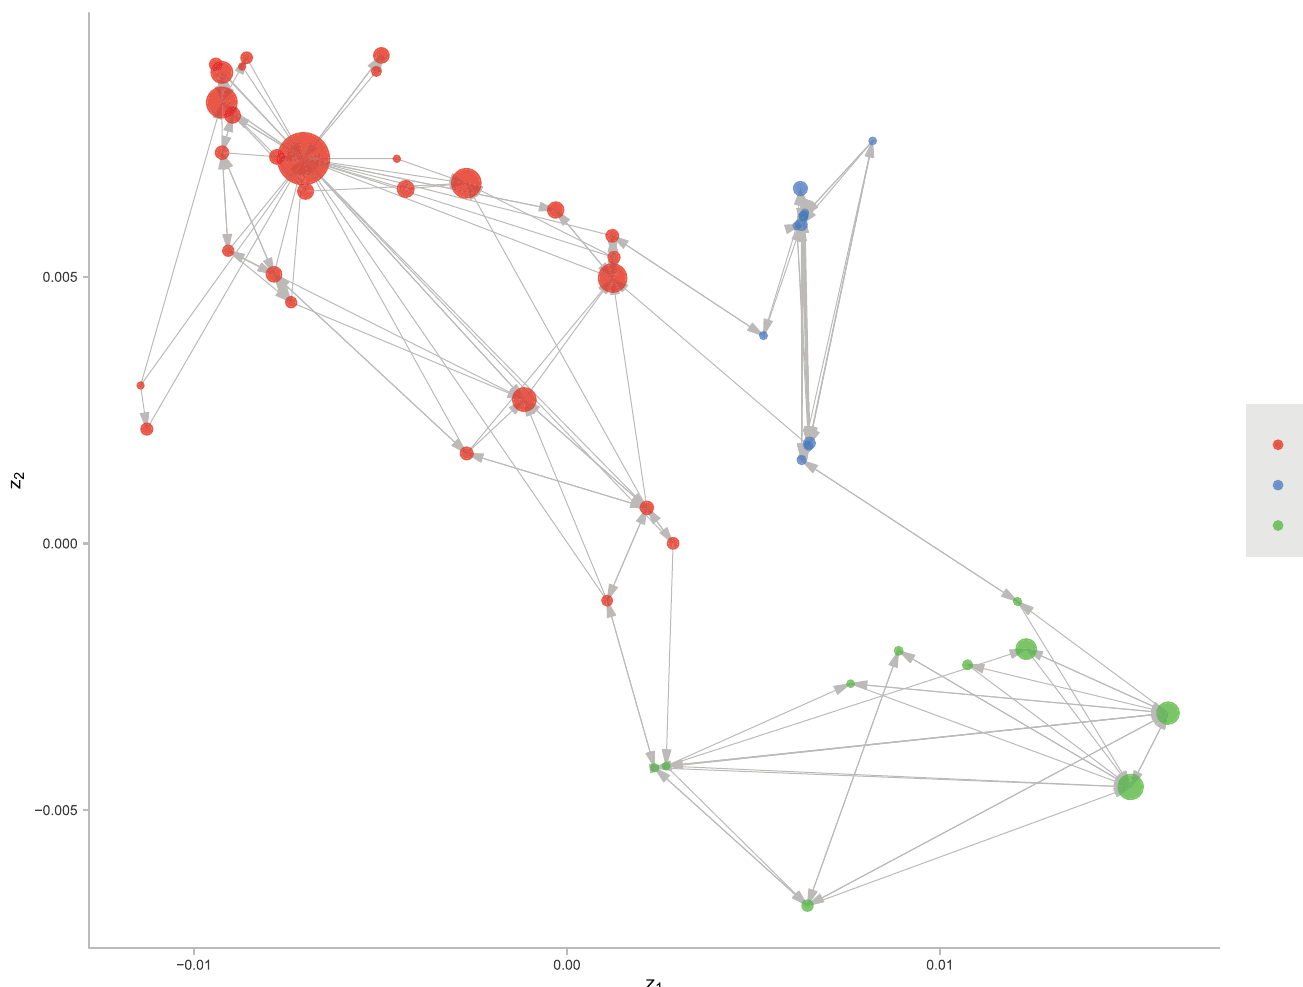
Fig 11. Directed graph with latent positions for the Twitter ego-network. The circles are located based on the estimated latent positions, and the directed edges denote the true relations of users. The colors and sizes of circles denote the true user clustering labels and estimated popularity scales respectively.